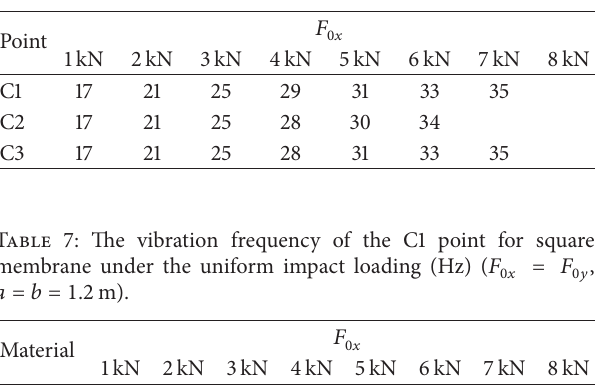
Table 6: The vibration frequency of the points for rectangle Xing